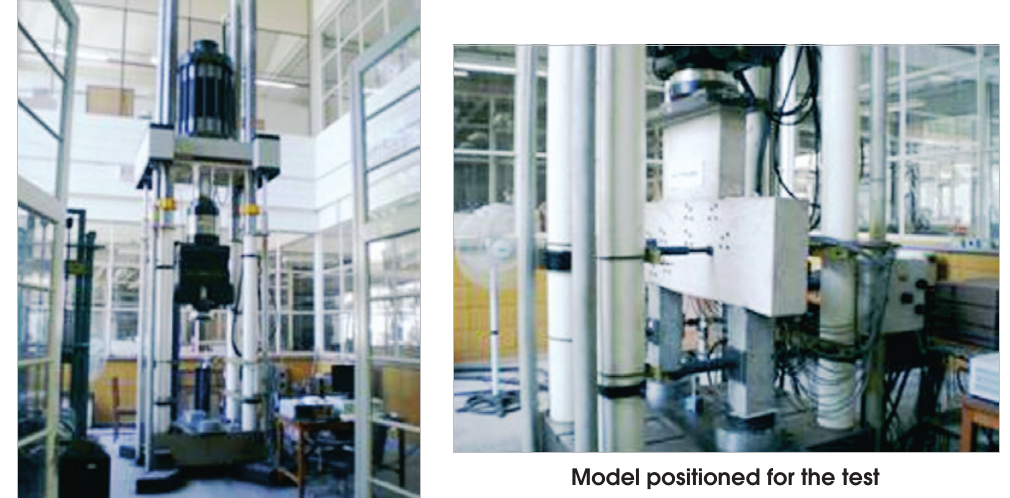
Model positioned for the